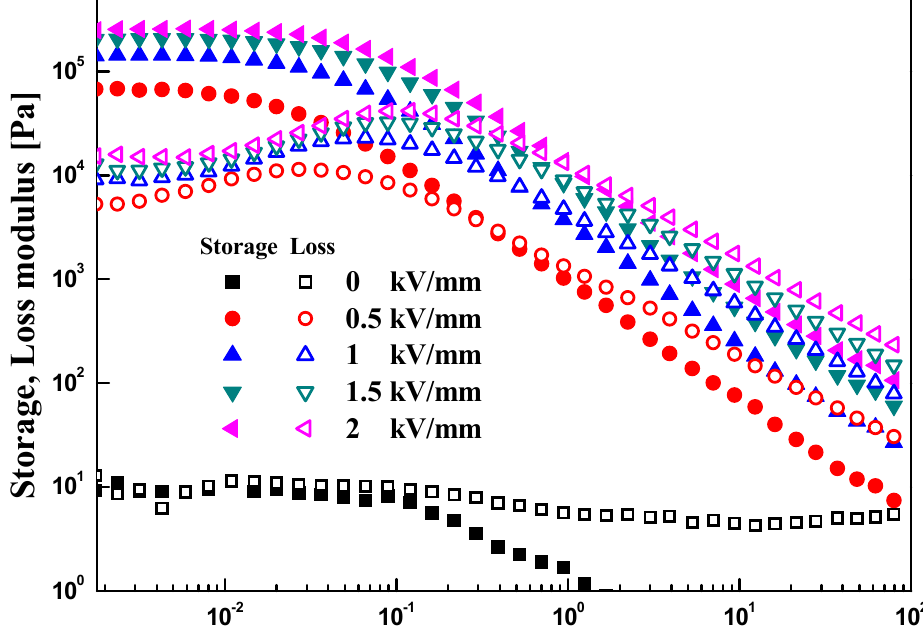
Figure 7. G (cid:48) (closed) and G (cid:48)(cid:48) (open) for the core–shell Fe 3 O 4 /POA particle-based ER suspension Figure 7. G ′ (closed) and G ″ (open) for the core–shell Fe 3 O 4 /POA particle-based ER suspension under different E s as a function of strain. under different E s as a function of strain.